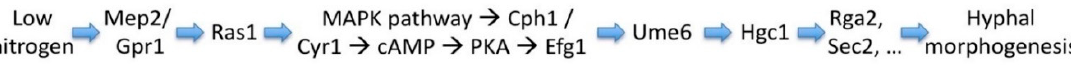
Figure 1. The simplified outline of one C. albicans hyphal morphogenesis signaling pathway. Figure 1. A simplified outline of one C. albicans hyphal morphogenesis signaling